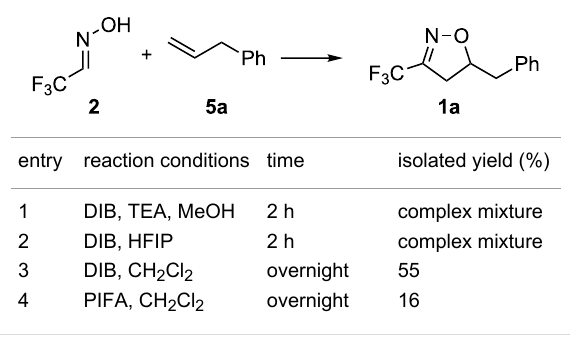
Figure 3: Dimerization of 4 yielding bis(trifluoromethyl)furoxan 6